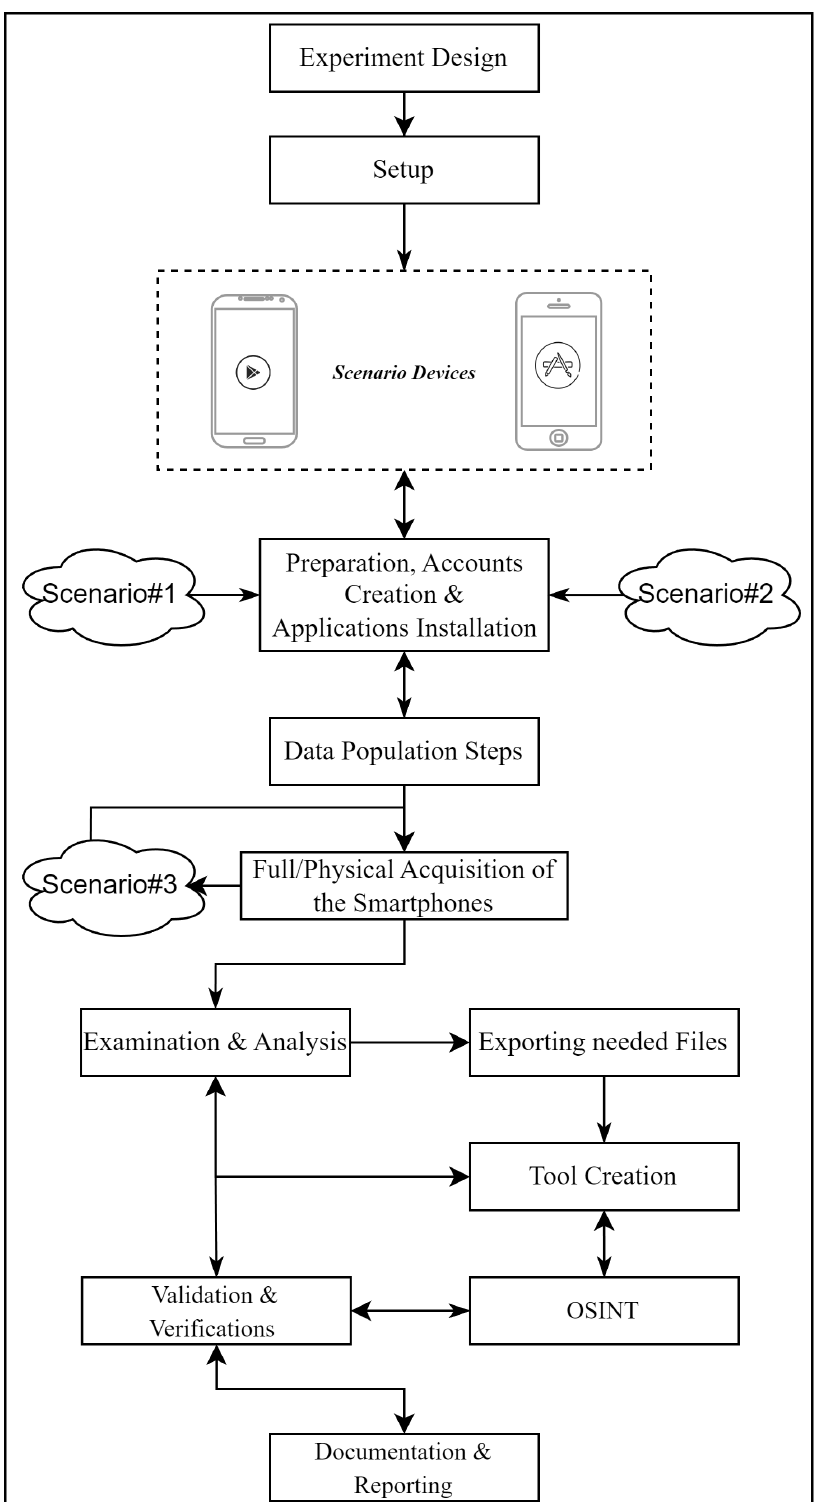
Figure 3. The research